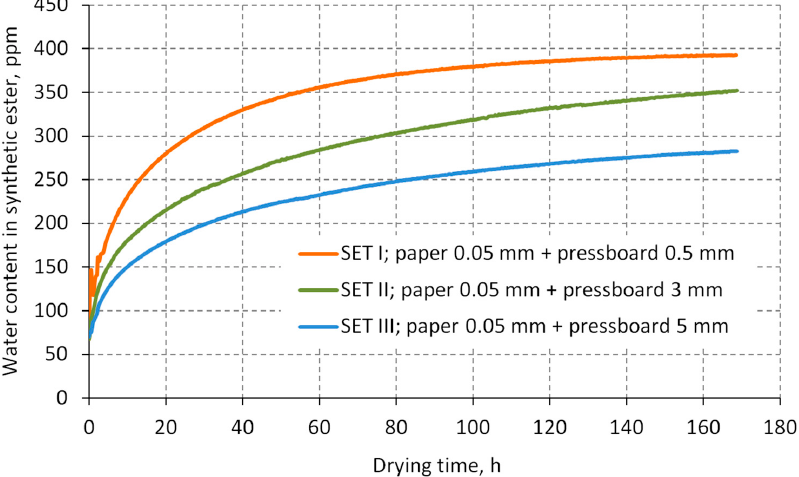
Figure 7. Water content in synthetic ester during the drying of SET I, SET II, SET III; drying temperature equal to 70 ° C.